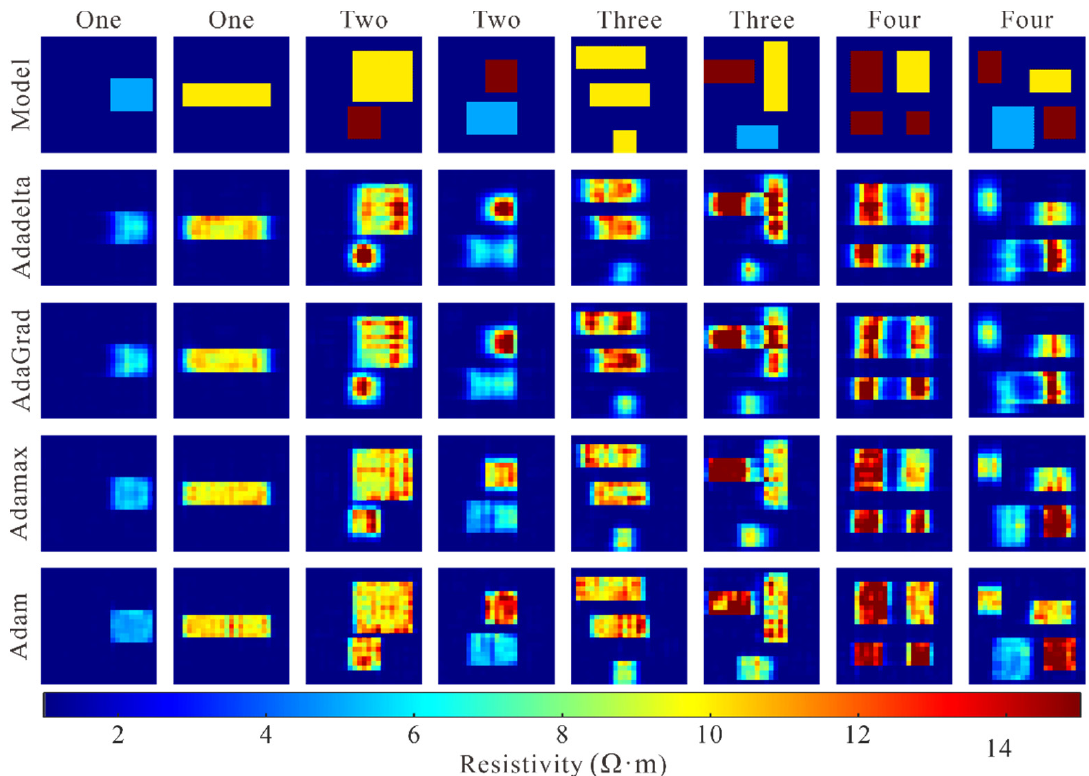
Figure 11. The model ′ s performance curve with different optimizers. ( a ) loss curve, ( b ) accuracy curve.